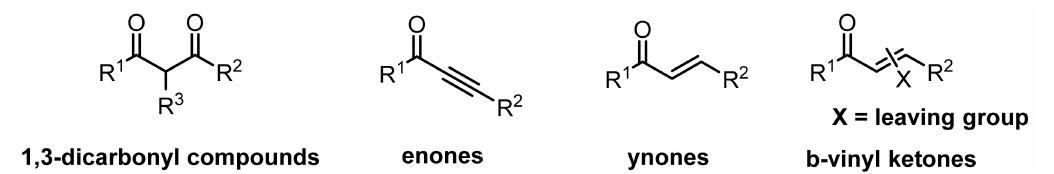
Figure 2. Structures of 1,3-dielectrophilic